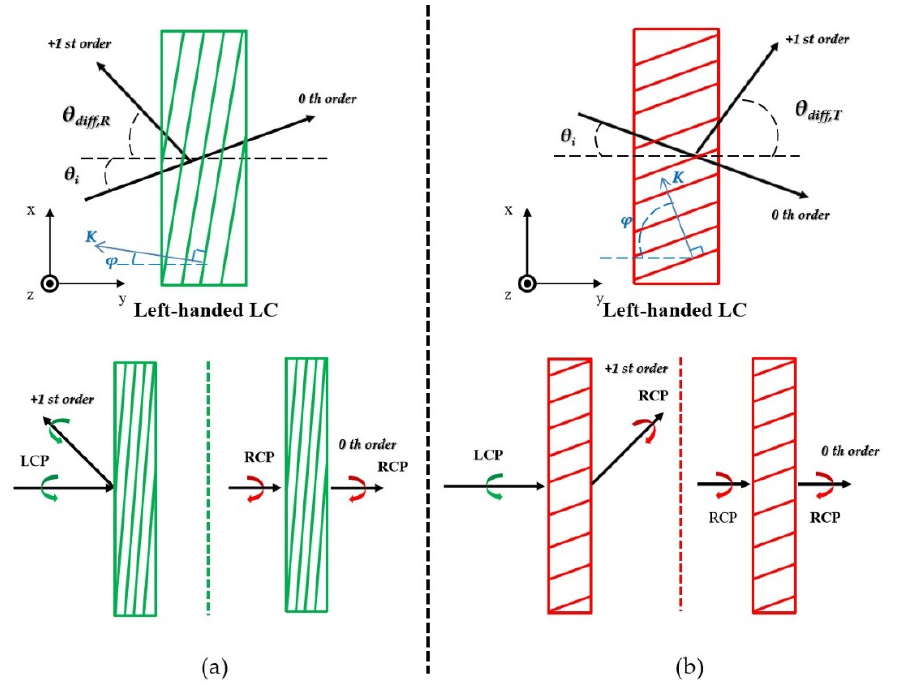
Figure 9. Schematic drawing of ( a ) reflective ( b ) transmissive left-handed Bragg gratings. Note that the 0th order is the transmitted beam without diffraction. Both gratings only diffract the circularly polarization state which has the same handedness of the LC